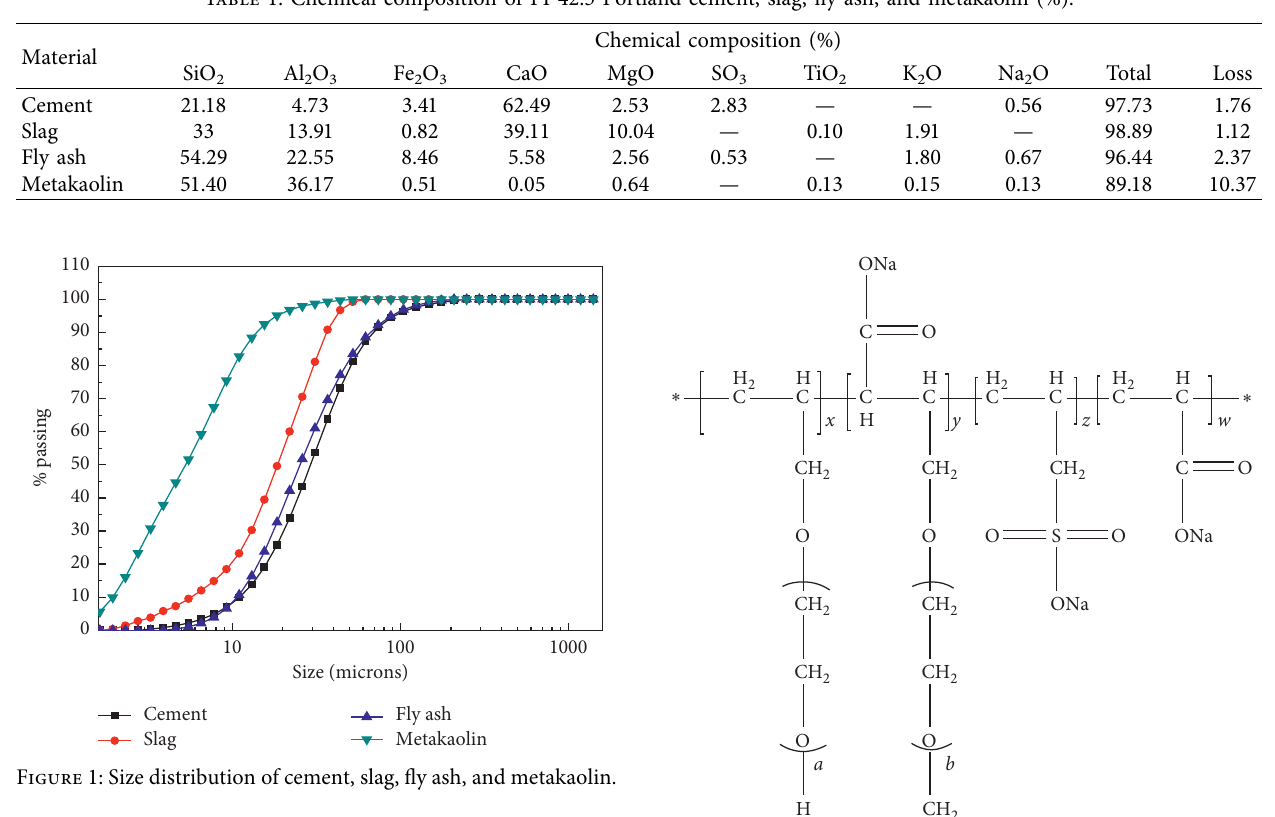
Table 1: Chemical composition of PI 42.5 Portland cement, slag, fly ash, and metakaolin (%).